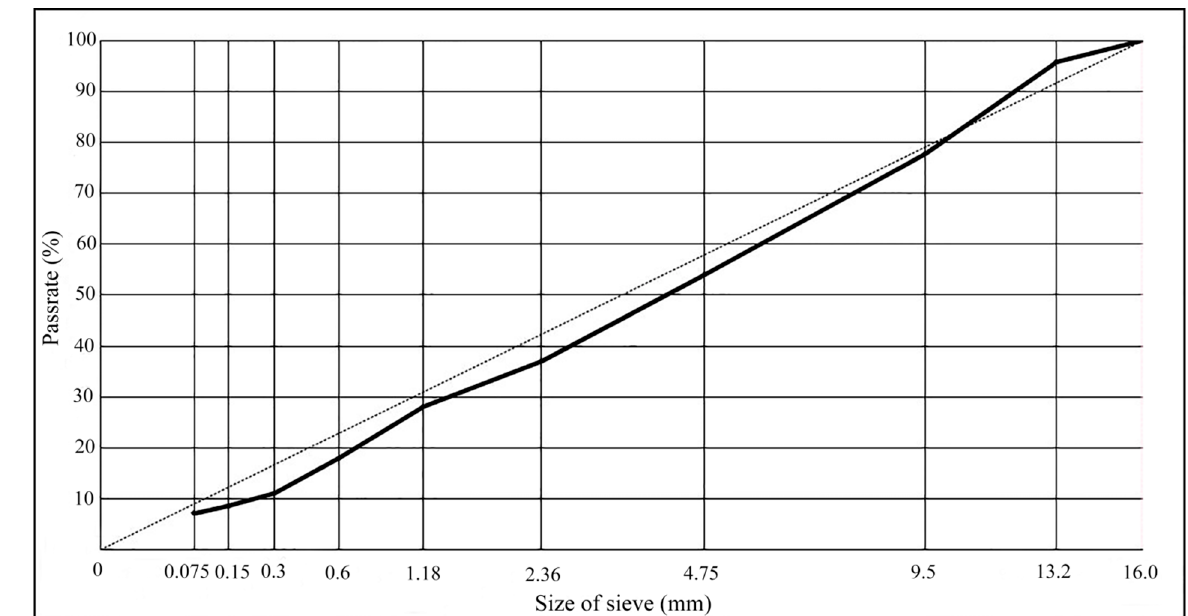
Figure 5. Aggregate gradation curve.